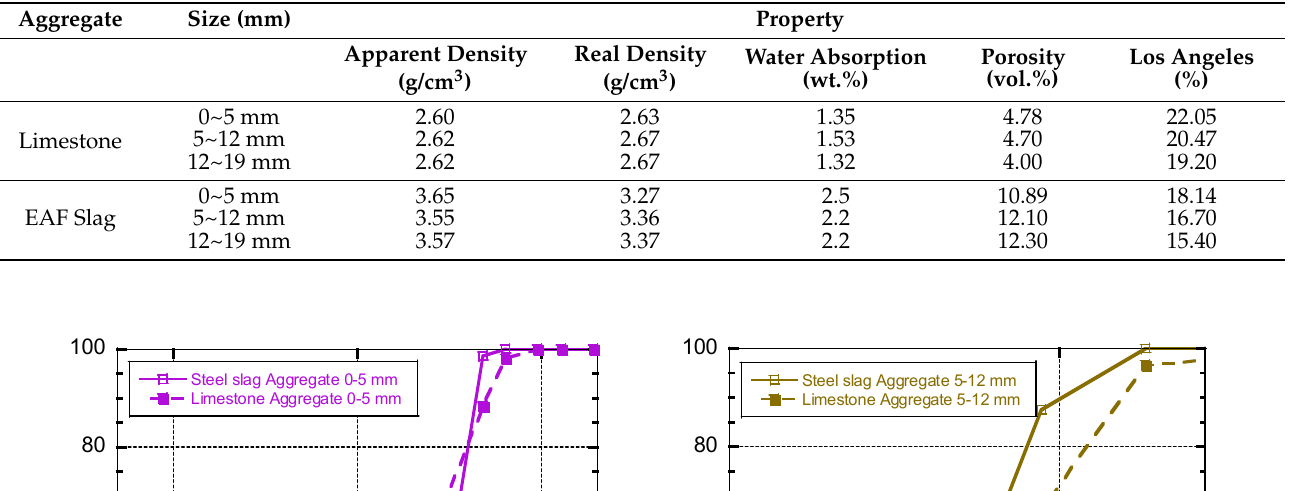
Table 4. Physical and properties of aggregates.